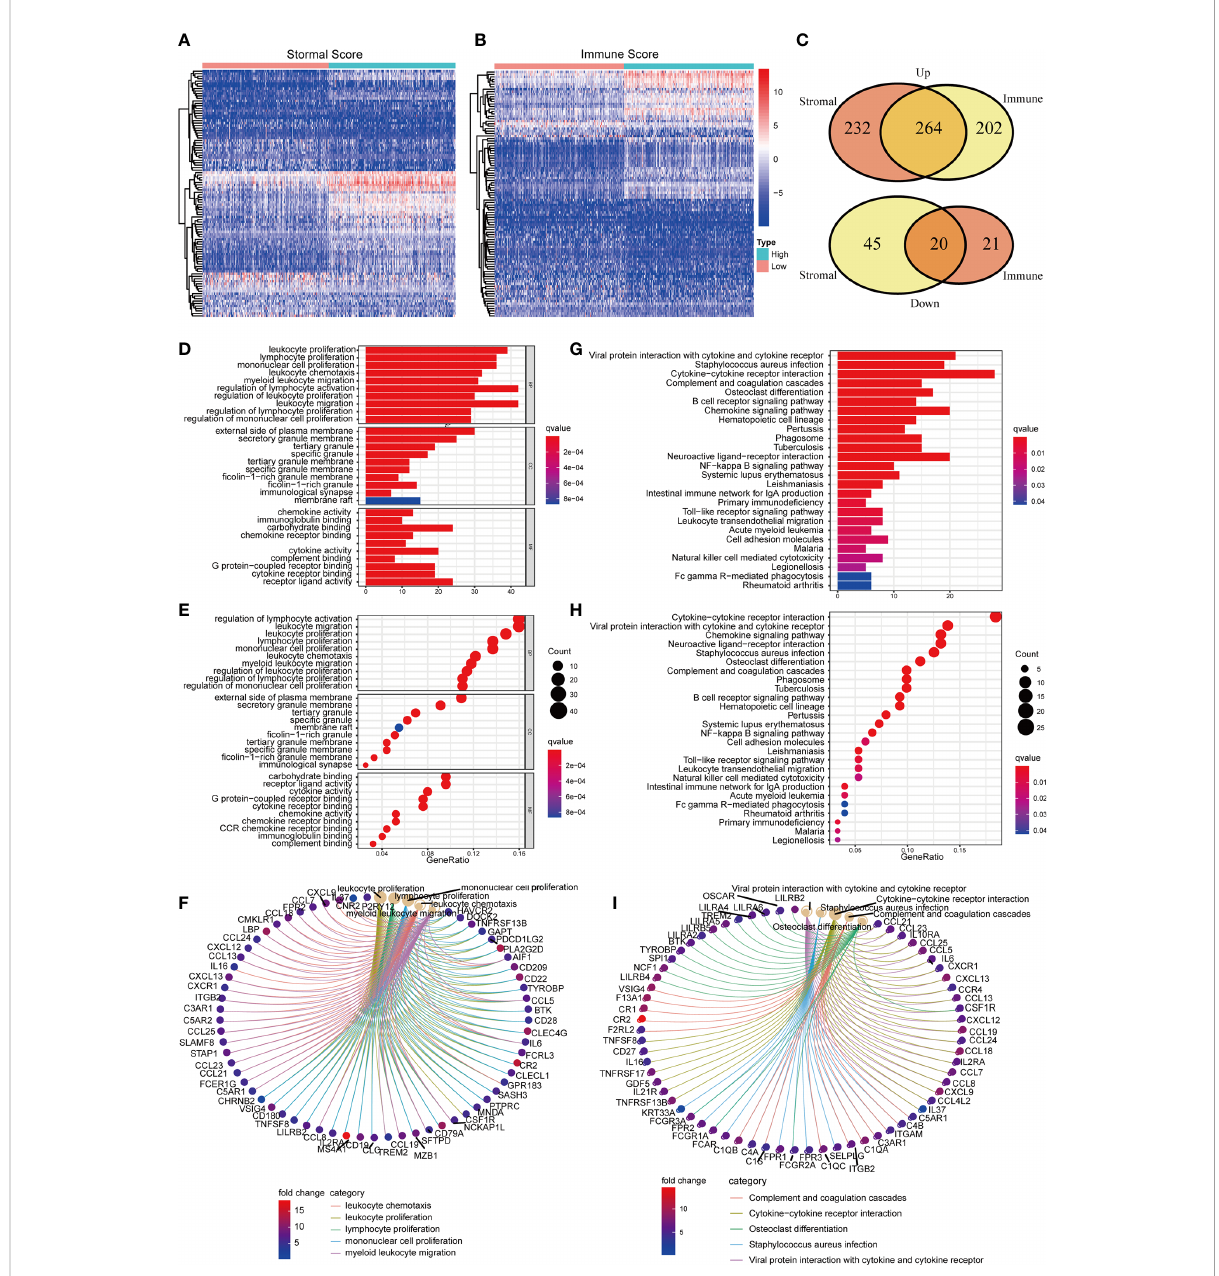
FIGURE 3 The identi fi cation and enrichment analysis of DEGs. (A, B) The heatmaps of DEGs obtained by comparison between high Stromal Score samples and low Stromal Score samples (or high Immune Score samples and low Immune Score). p<0.05, FDR<0.05 and log2 FC > 2 were set up to scan the DEGs; (C) Venn plots of DEGs which were commonly up-regulated or down-regulated in both Immune and Stromal Score; (D – F) GO enrichment analysis of 284 DEGs; p<0.05 was considered to be statistically signi fi cant; BP, biological process; CC, cell component; MF, molecular function; (G – I) KEGG enrichment analysis of 284 DEGs; p<0.05 was considered to be statistically signi fi